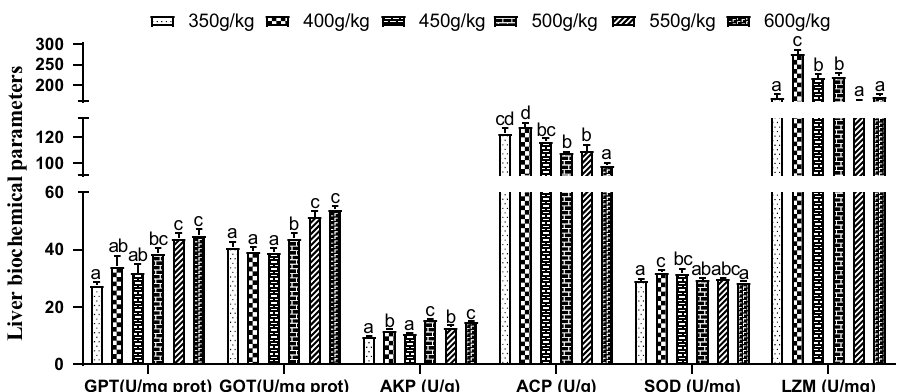
Figure 3. Effect of dietary protein level on liver biochemical parameters and immune enzyme activities of juvenile orange-spotted grouper. Values are means ± SD (n = 3). Different letters assigned to the bars represent significant differences using Duncan’s multiple comparison ( P < 0.05). GPT glutamic-pyruvic transaminase, GOT glutamic oxaloacetylase, AKP alkaline phosphatase, ACP acid phosphatase, SOD superoxide dismutase, LZM lysozyme.